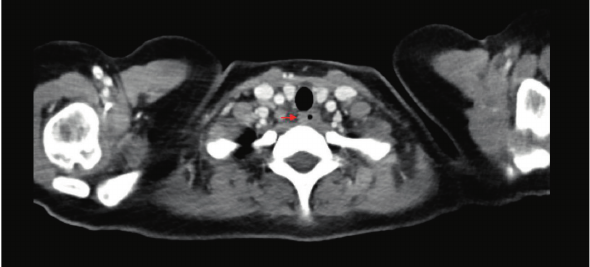
Figure 3: CT chest/abdomen/pelvis demonstrating diffuse, cir- cumferential esophageal thickening as denoted by red arrow.